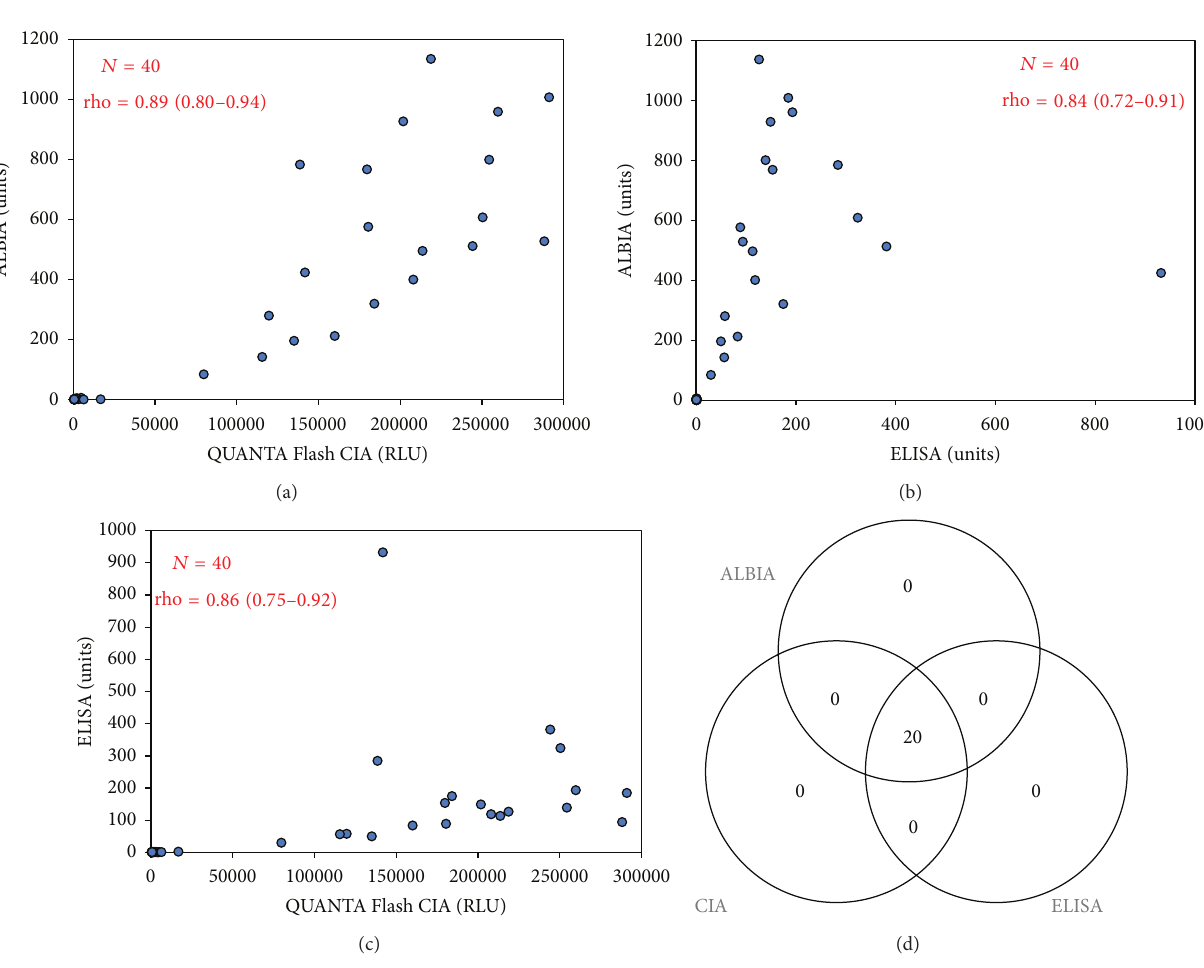
Figure 2: Correlation of anti-HMGCR antibodies detected using different methods. Spearman correlation diagrams are shown in (a)– (c) and a Venn Diagram in (d). All assays show good qualitative and quantitative agreements. ALBIA: addressable laser bead assay; CIA: chemiluminscent immunoassay; RLU: relative light